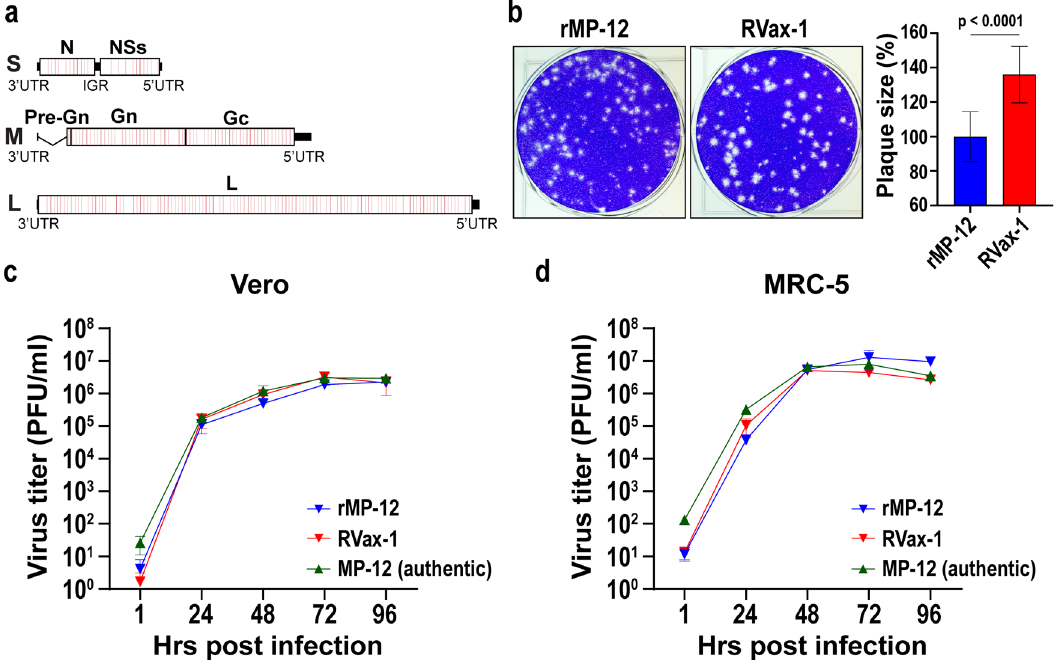
Fig. 1 Genetic structure and growth kinetics of RVax-1 in Vero or MRC-5 cells. a Schematic representation of the RVax-1 S, M, and L segments, which encode a deletion at nt. 21 – 384 in the M-segment, and 566 silent mutations throughout the N, M, and L ORFs. Locations of individual silent mutations are labeled in red lines, which are found as a cluster every 50 nt. b Plaque phenotypes of rMP-12 and RVax-1 in Vero cells at 4 dpi. The graph represents the means ± standard deviations of relative diameter lengths from 20 randomly selected plaques. Unpaired t -test was used for the comparison of two groups ( t = 7.319, df = 38). Vero cells ( c ) or MRC-5 cells ( d ) were infected with MP-12 vaccine lot-7-2-88, rMP-12 or RVax-1 in Vero cells at MOI 0.01. Virus replication kinetics at 35 °C are shown. Means ± standard deviations of triplicate wells are